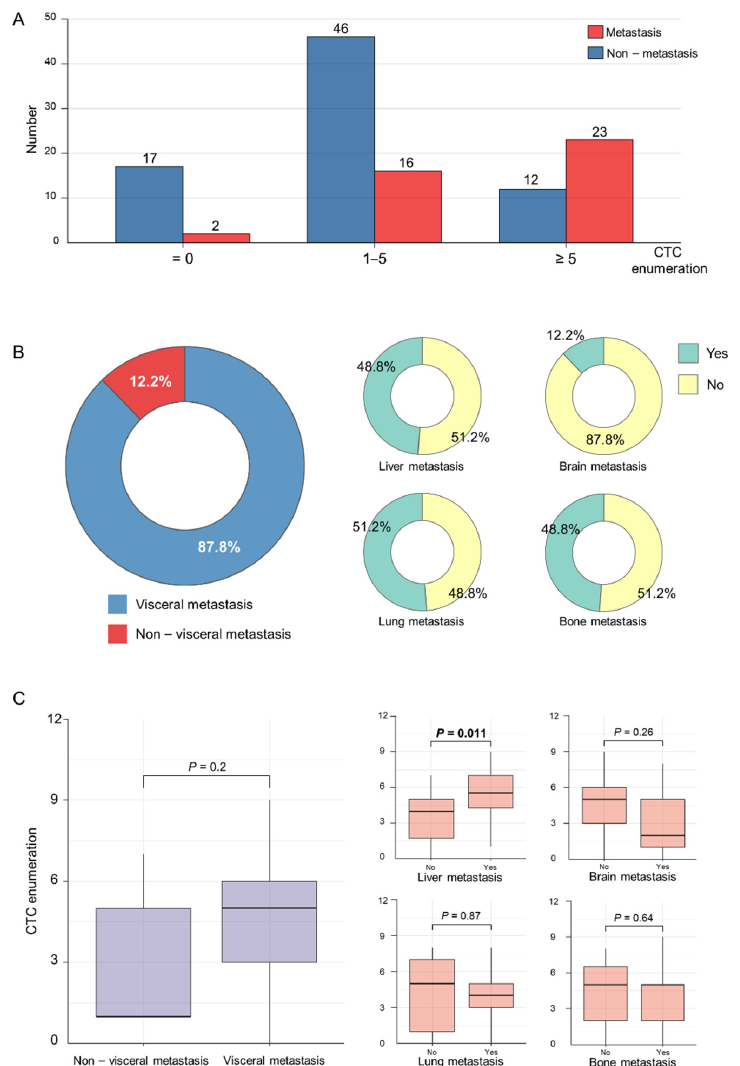
Figure 1. Circulating tumor cells enumeration and tumor metastasis site. ( A ) The number of patients across different CTC enumeration categories (CTCs = 0, 1–5, and ≥ 5). ( B ) The constituent ratio of organ-specific metastasis in patients with metastatic breast cancer. Constituent ratios are shown in visceral, liver, brain, lung, and bone metastasis, respectively. ( C ) CTC enumeration in different me- tastasis sites. CTC enumeration in different groups was compared by the Wilcox test. The bold for- mat means statistics significant. Abbreviation: CTC—circulating tumor cell.